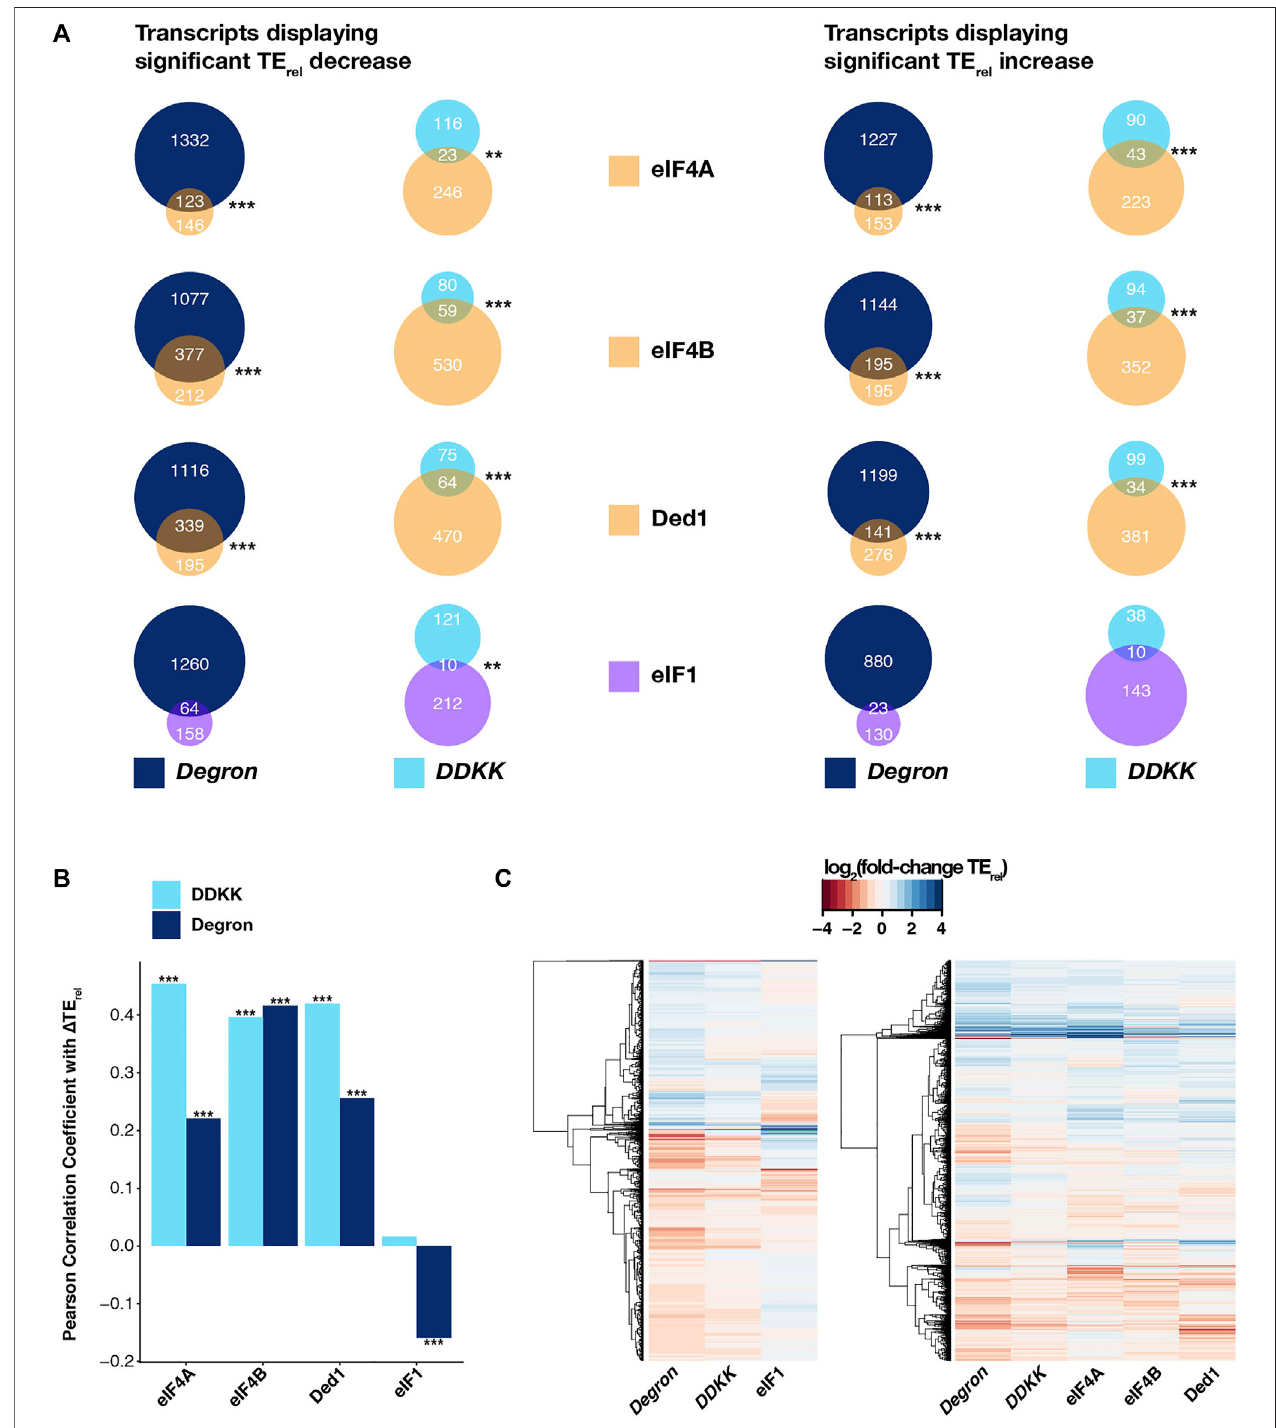
FIGURE4 | The effects ofdisruption ofthe entire eIF3complexor its mRNA-entry-channel arm are similar to thoseobserved for mutations targeting other initiation factors involved in mRNA recruitment. (A) Venn diagrams showing the overlap between mRNAs displaying either TE rel decreases (left) or increases (right) in eIF3a/b Degron (darkblue)or eIF3iDDKK (lightblue)cellsandcellsexpressingmutationstargetingotherinitiationfactorsthatcontributetomRNArecruitment(eIF4A,eIF4B,and Ded1; light orange) or to start-codon recognition (eIF1, purple). *** (cid:1) P < 10 − 10 , ** (cid:1) P < 10 − 5 , * (cid:1) P < 0.05, HyperGeometric test. (B) Bar plot showing Pearson correlation coef fi cients obtained when comparing Δ TE rel values observed in eIF3a/b Degron (dark blue) or eIF3i DDKK (light blue) cells and those observed in cells expressing mutations targeting eIF4A, eIF4B, Ded1, or eIF1. *** (cid:1) P < 10 − 10 , ** (cid:1) P < 10 − 5 , * (cid:1) P < 0.05. (C) Heatmap and dendrograms resulting from hierarchical clustering analysis of signi fi cant TE rel changes observed in eIF3a/b Degron and eIF3i DDKK cells and cells with mutations targeting either eIF1 (left) or eIF4A, eIF4B, and Ded1 (right).